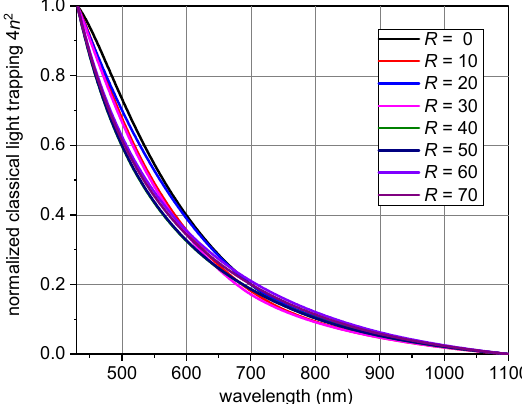
Figure 4. Normalized classical light trapping limit.